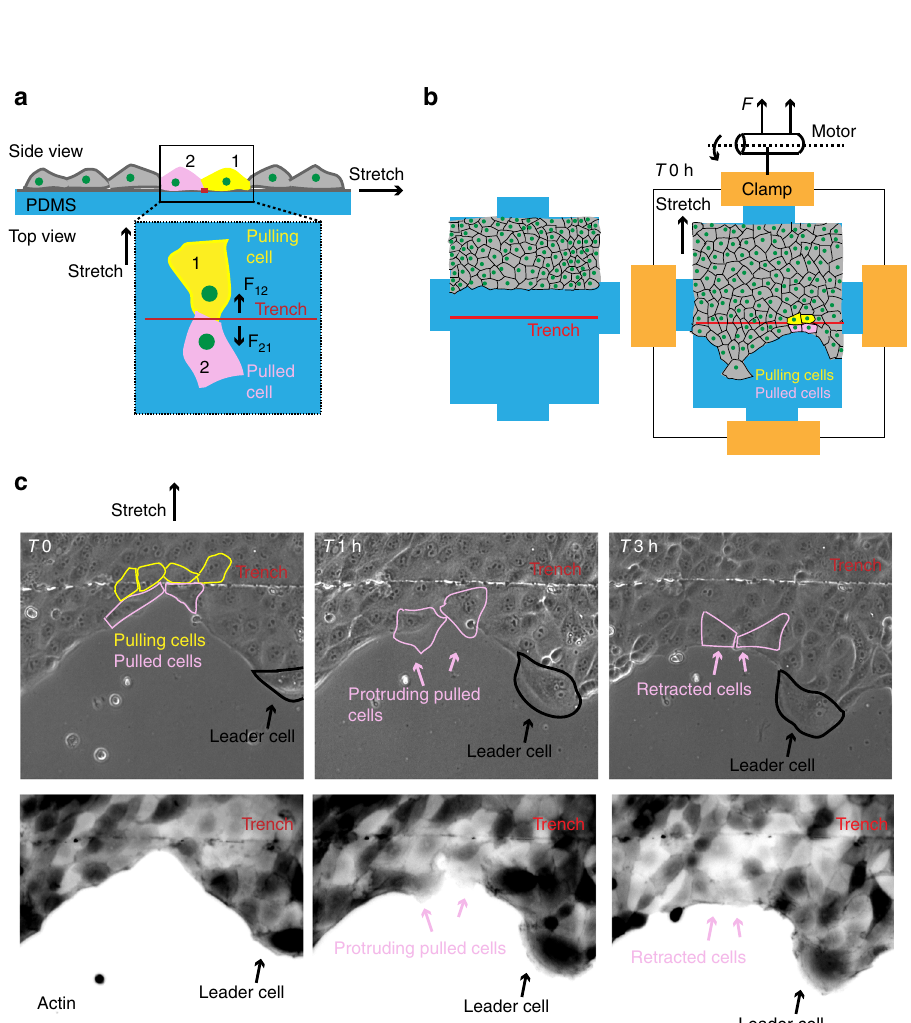
Fig. 5 Followers pull on the future leader cells. a Schematic illustration showing side view and top view of the cell-pulling experiment. Cells seeded on PDMS substrates (in blue) with a fi ne trench (in red). Upon uniaxial stretching, cells on one side of the trench exert pulling forces on cells on the other side (F12 and F21). b Cell monolayer seeded on the PDMS substrate containing a fi ne trench (in red) about 100 μ m away from the cells, con fi nement was released and cells were allowed to migrate until one row of cells cross the trench at various locations (right panel). c Representative time lapse phase contrast images (top panel) and actin images (bottom panel) showing cells moving on PDMS substrate with a trench. Upon stretching, cells ahead of the trench protrude due to the pulling force from behind (middle panel). These protruding cells however retract, likely due to the existing pulling force coming from the leader at the tip of the outgrowth (right panel). Scale bar = 100 μ m